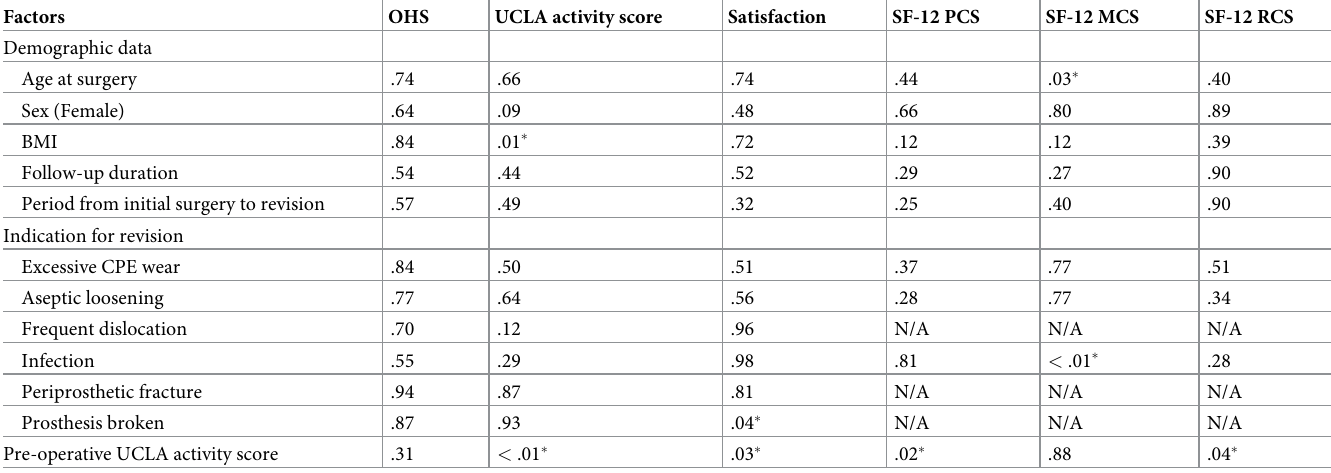
Table 5. Factors influencing PROMs in revision